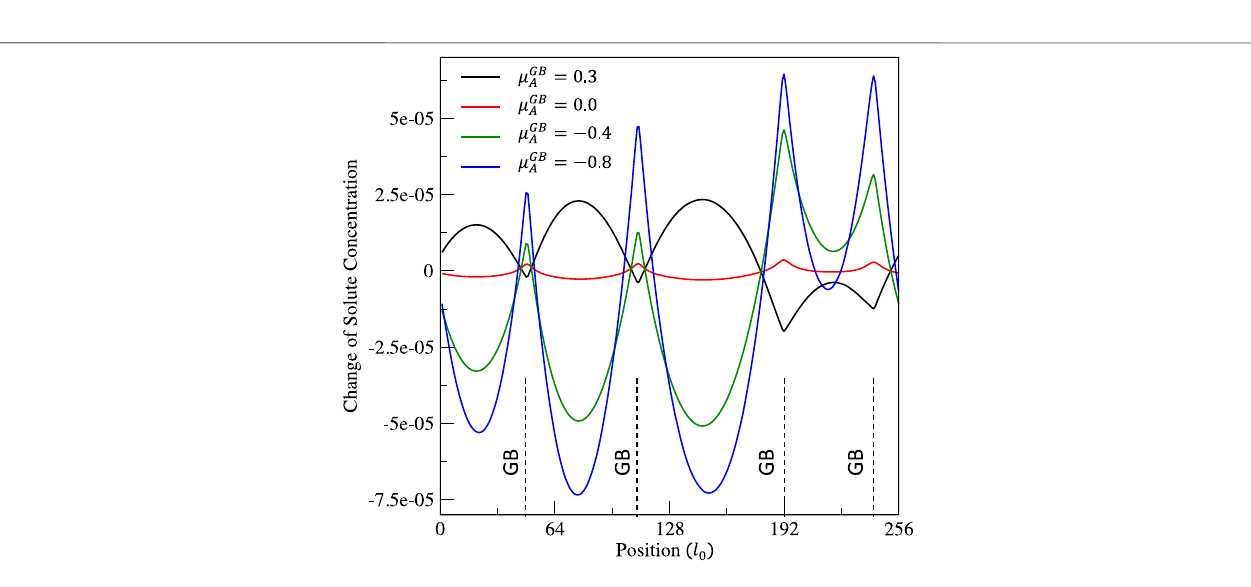
Frontiers in Materials |